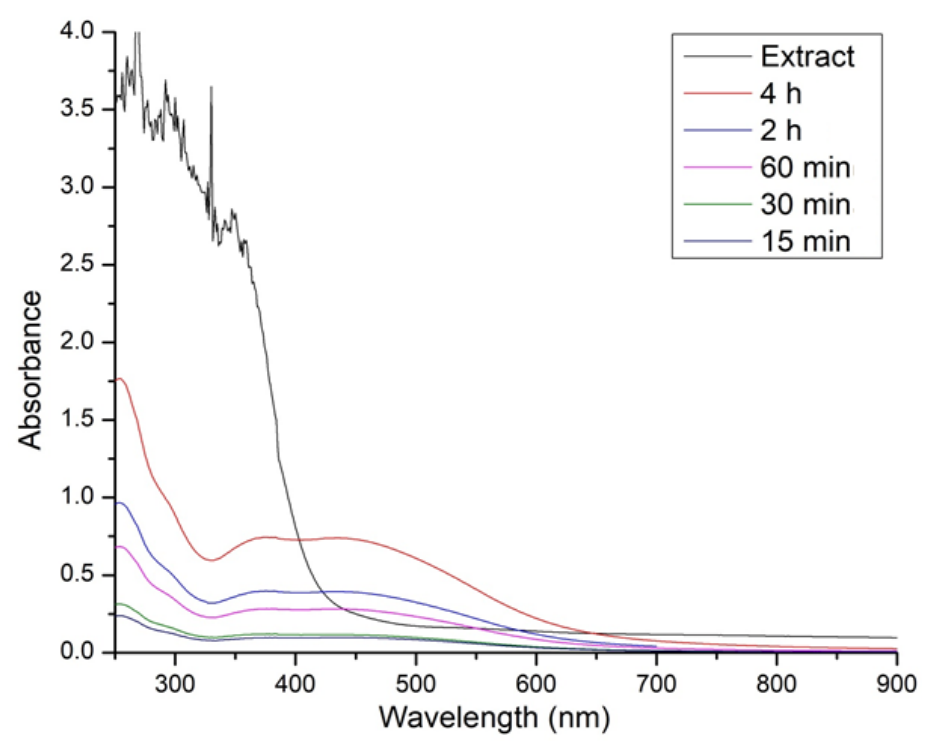
Materials 2022 , 15 , 6978 Figure 2. Representative of UV-Vis of silver nanoparticles at different time intervals. Figure 3 is indicative of SEM, which shows that nanoparticles have not formed, but are clumped, and neither aggregated nor uniformly distributed, whereas the TEM image is indicative of the size of nanoparticles, which was 52 nm (average size). TEM also shows that the nanoparticles are of varying shapes and sizes. Figure 4b represent the particle size distribution of nanoparticles via a histogram.